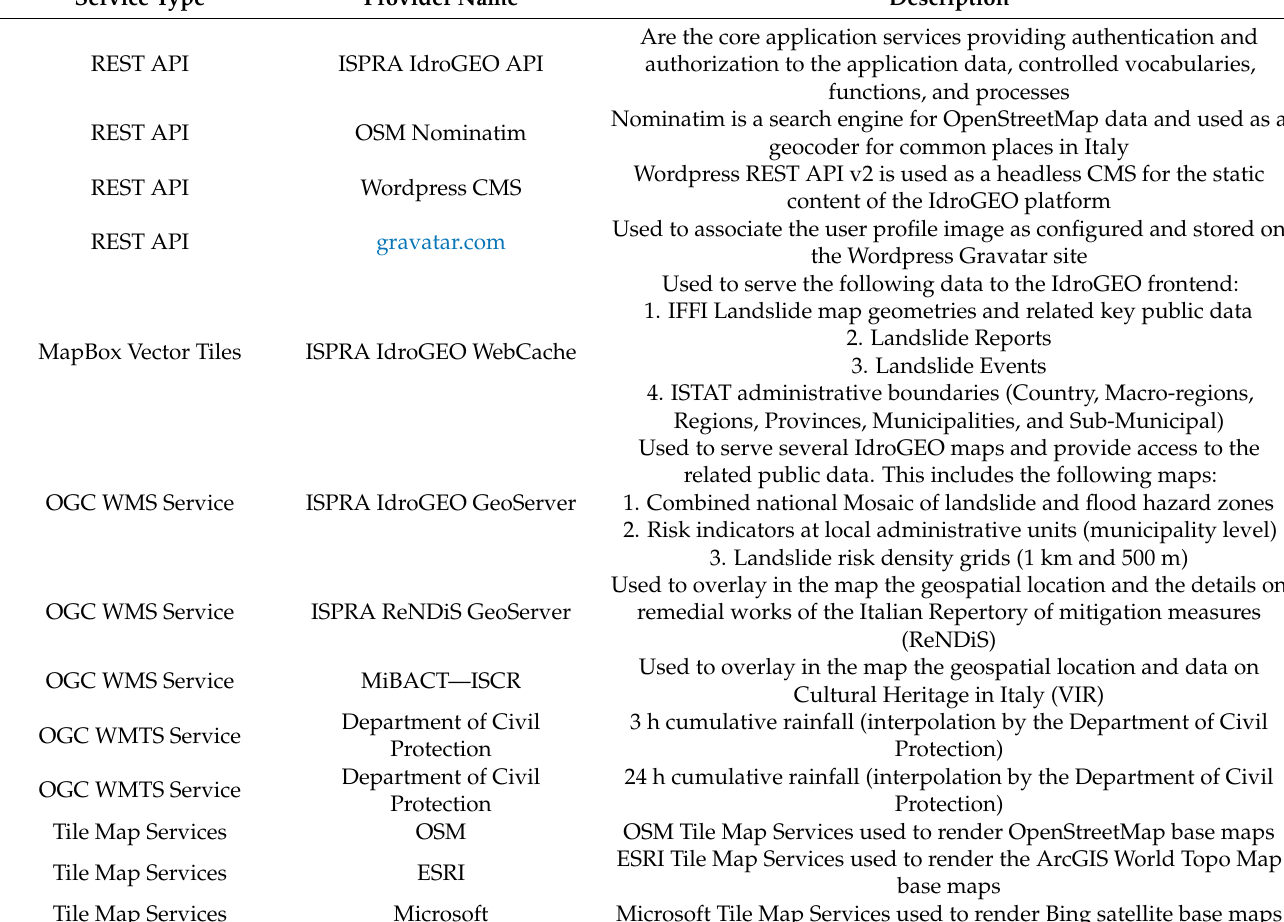
Table 2. Services of the IdroGEO